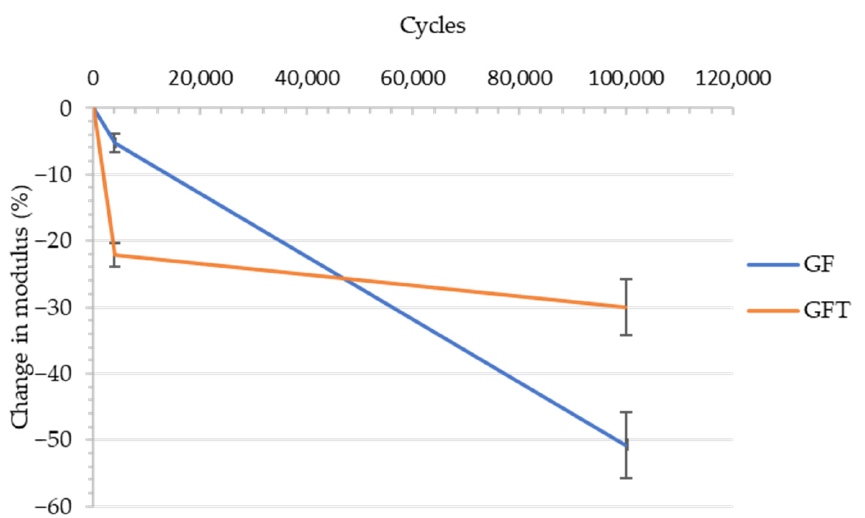
Figure 12. Flexural moduli change after 4000 and 100,000 cycles for GF and GFT loaded at 70% maximum flexural loading.